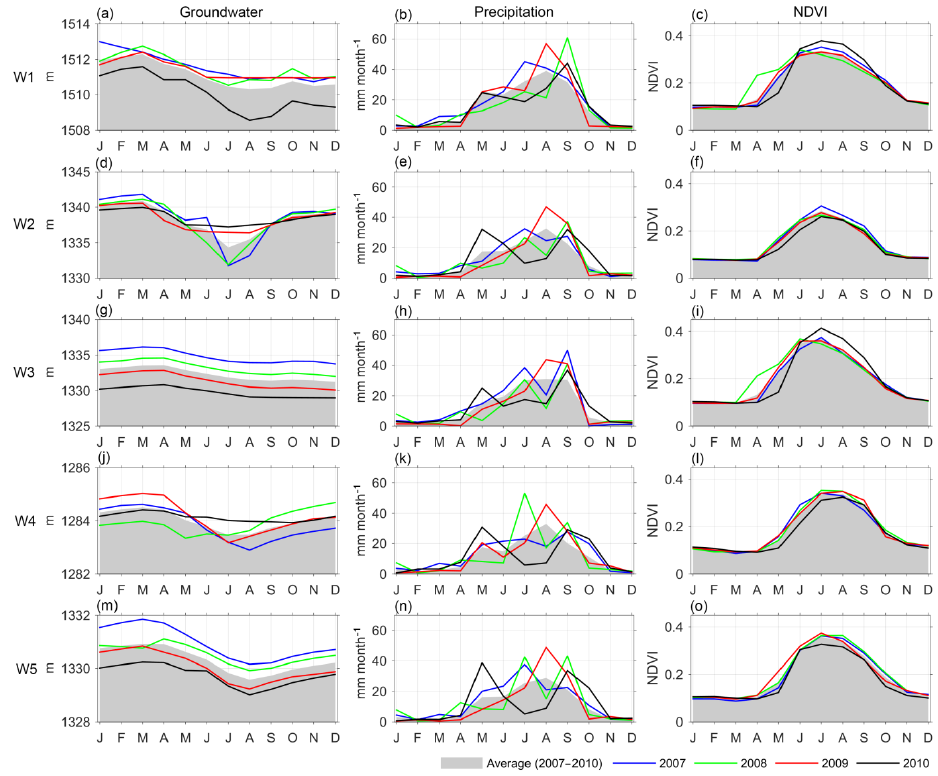
Figure 15. The monthly averaged groundwater head measurement (left), total precipitation (middle), and NDVI (right) for five groundwater well locations. Precipitation and NDVI data are reported as the average values within the circular areas of the 10km radius. The long-term average values between January 2007 and December 2010 are shown in the grey shading, and the values in 2007, 2008, 2009, and 2010 are shown as blue, green, red, and black lines, respectively. The period is chosen based on the availability of the well